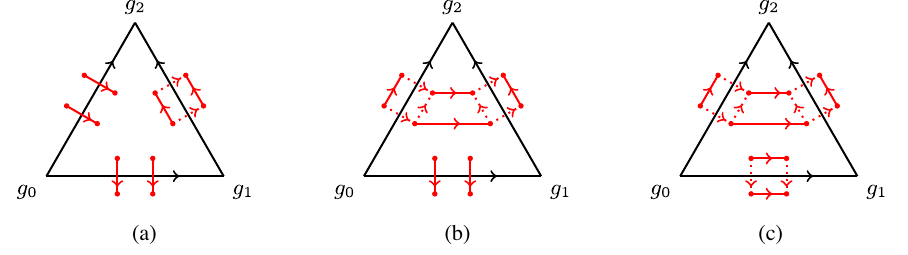
FIG. 14. Different effective Majorana chain configurations and their total fermion parities P ψ calculated by counting the number of length-4 (non-Kasteleyn-oriented) loops in the figures. (a) ω 2 ð g fermion parity P ψ with fermion parity P ψ